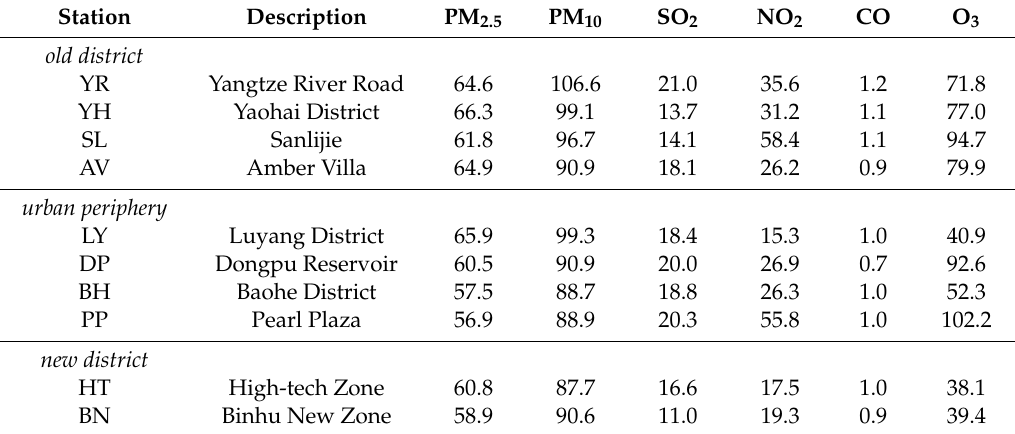
Table 3. Average diurnal concentrations of six criteria air pollutants at ten stations in Hefei during